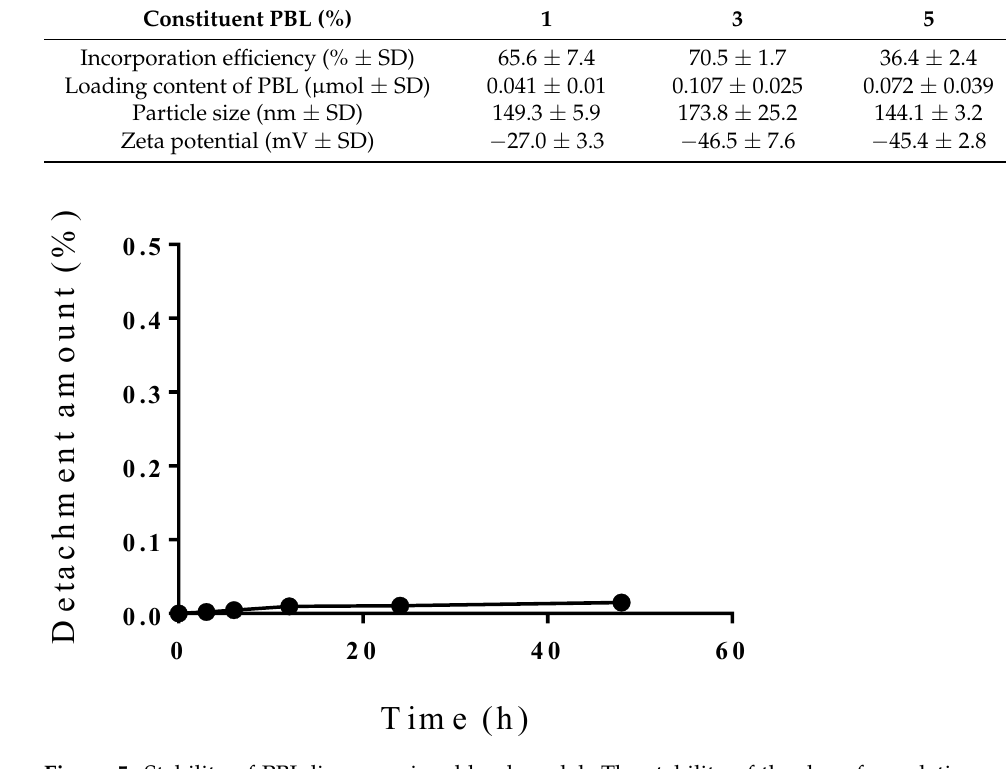
Figure 5. Stability of PBL liposome in a blood model. The stability of the drug formulation was evaluated by measuring the detachment of PBL from the PBL liposomes (PBL content of 5%) for 48 h in fetal bovine serum at 37 °C. Values indicate the total amount of PBL detachment at the indicated time point ( ● ).